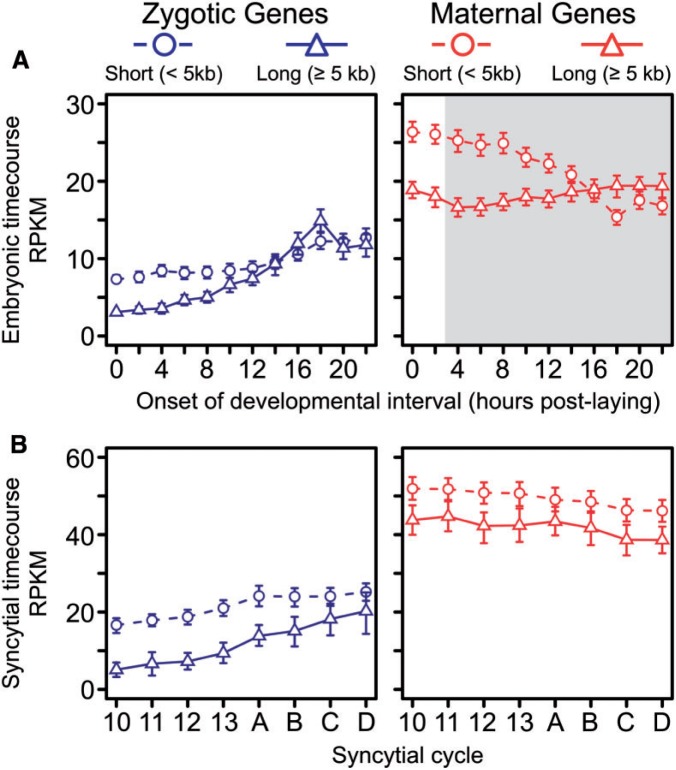
Long, zygotically expressed transcripts show delayed expression in both the embryonic and syncytial timecourses. Median expression levels (with 95% confidence intervals) for zygotic (blue) and maternal (red) genes over the embryonic (A) and syncytial (B) timecourses. The area shaded in gray indicates postgastrulation time points during which expression levels of maternally deposited genes may include significant contribution from zygotic transcription. Short (<5 kb) and long genes (≥5 kb) are indicated as circles and triangles, respectively. Letters A–D in the syncytial timecourse indicate the four consecutive time points collected during the extended 14th mitotic cycle. Median expression levels of both zygotic gene length classes increase over both the embryonic and syncytial timecourses; however, the difference in expression level between two length categories becomes smaller over subsequent stages of development, as predicted by the intron delay hypothesis. Neither length category increases significantly among maternal genes.